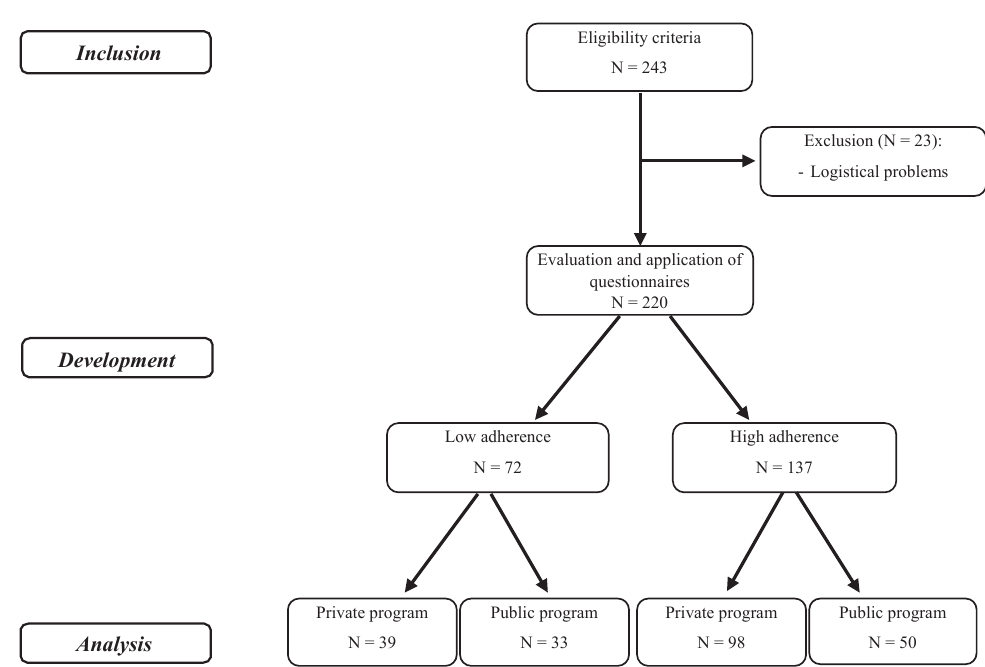
Fig. 1 - Patients’ distribution